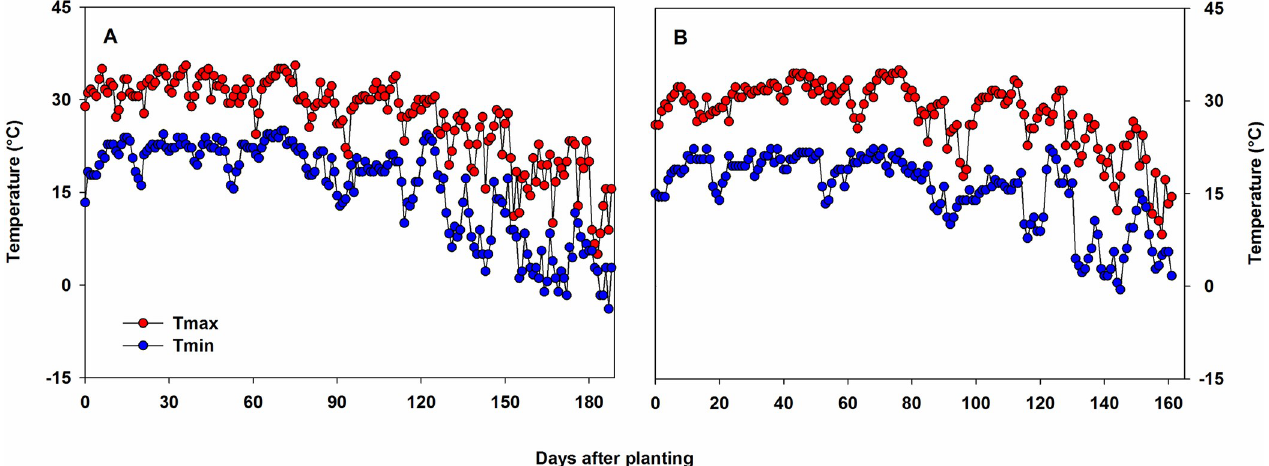
Fig 2. Daily maximum (Tmax) and minimum (Tmin) temperatures from planting through the end of the season at Florence, SC, USA (a) and Pendleton, SC, USA (b). Temperature data were obtained from the National Centers for Environmental Information (NCEI) of National Oceanic and Atmospheric Administration (NOAA). Soybean genotypes were planted on 9 June 2017 at Florence and 8 June 2017 at Pendleton. The duration of the crop season was 188 and 161 d at Florence and Pendleton, respectively.